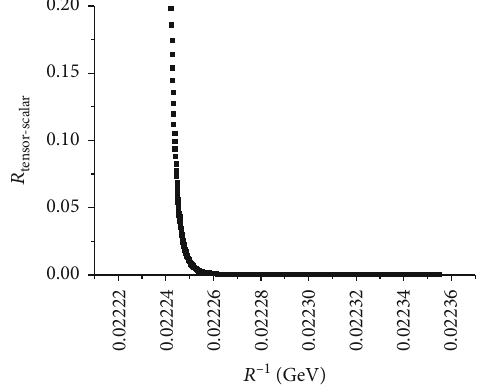
= 0 : 45 ð GeV Þ − 1 , ω = 4 : 6 ð GeV Þ , 0